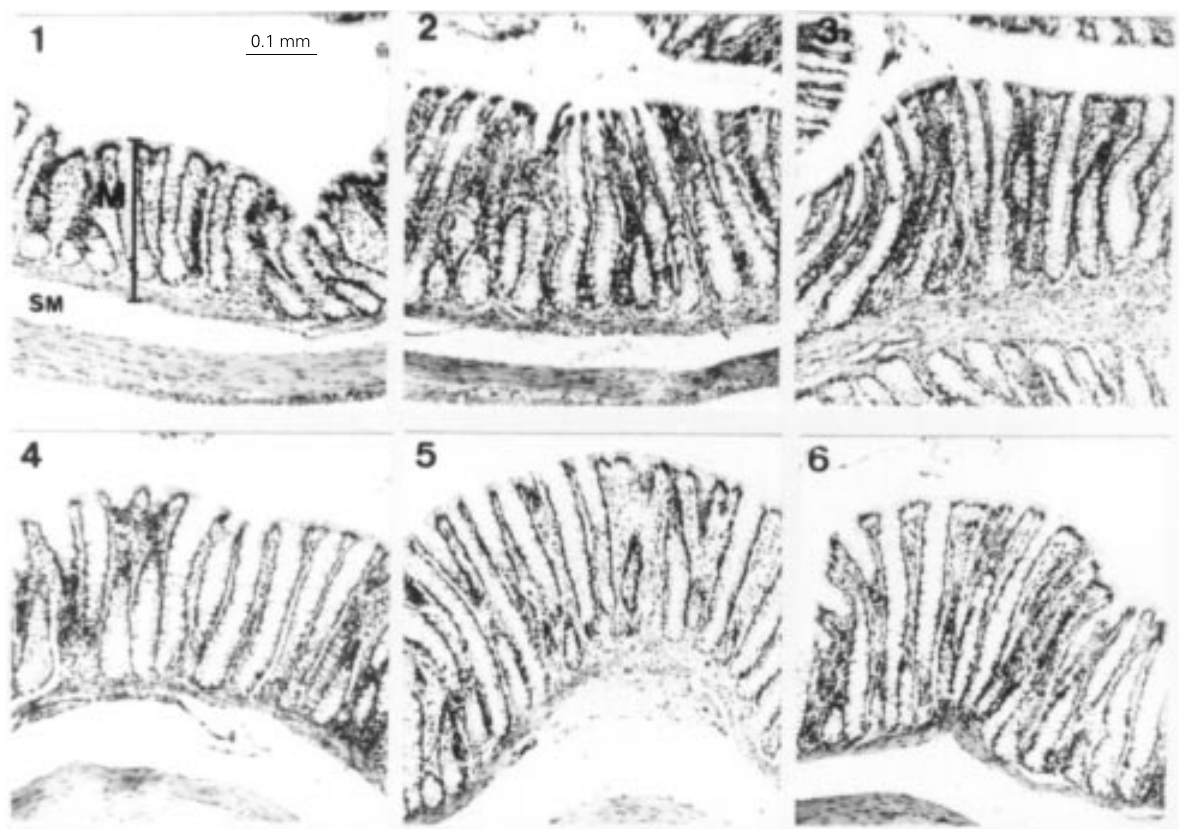
Figure 2 - Photomicrographs of the colon mucosa from mature (1, 2 and 3) and aged (4, 5 and 6) rats fed a control diet (1 and 4) or diets enriched with oat bran (2 and 5) or wheat bran (3 and 6). The tissues were prepared as described in Material and Methods and stained with hematoxylin and eosin (X100). The mucosal height is indicated by the vertical bar. The horizontal magnification bar corresponds to 0.1 mm. M, Mucosa; SM,